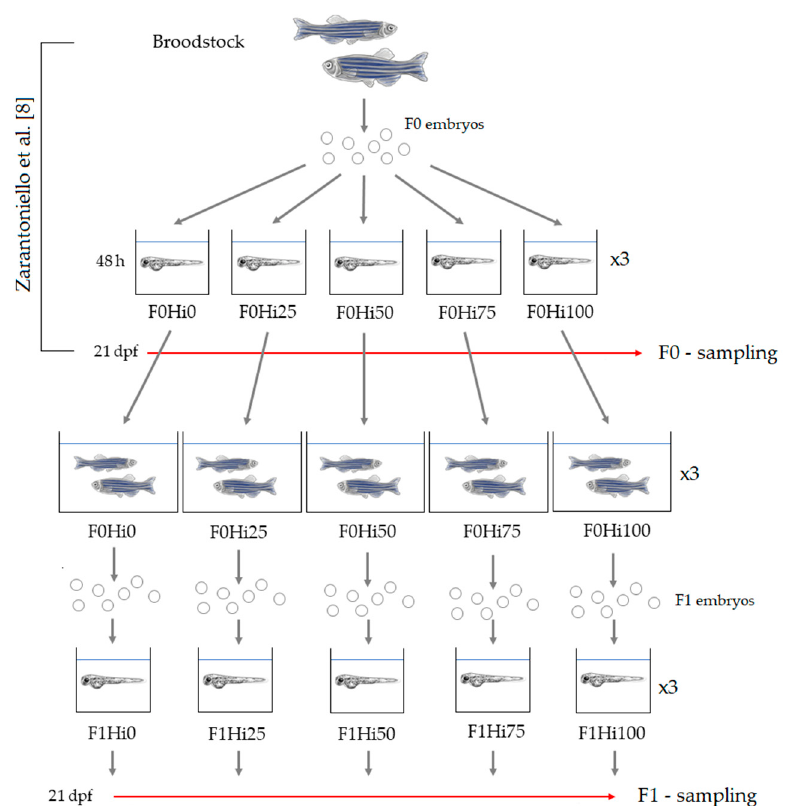
Figure 1. Schematic representation of the experimental design. Fish-fed diets including 0%, 25%, 50%, 75% and 100% of BSF meal respect to FM (F0Hi0, F0Hi25, F0Hi50, F0Hi75 and F0Hi100 for F0 zebrafish and F1Hi0, F1Hi25, F1Hi50, FiHi75 and F1Hi100 for F1 zebrafish larvae). dpf–days post fertilization; F0–parental generation; F1–first filial